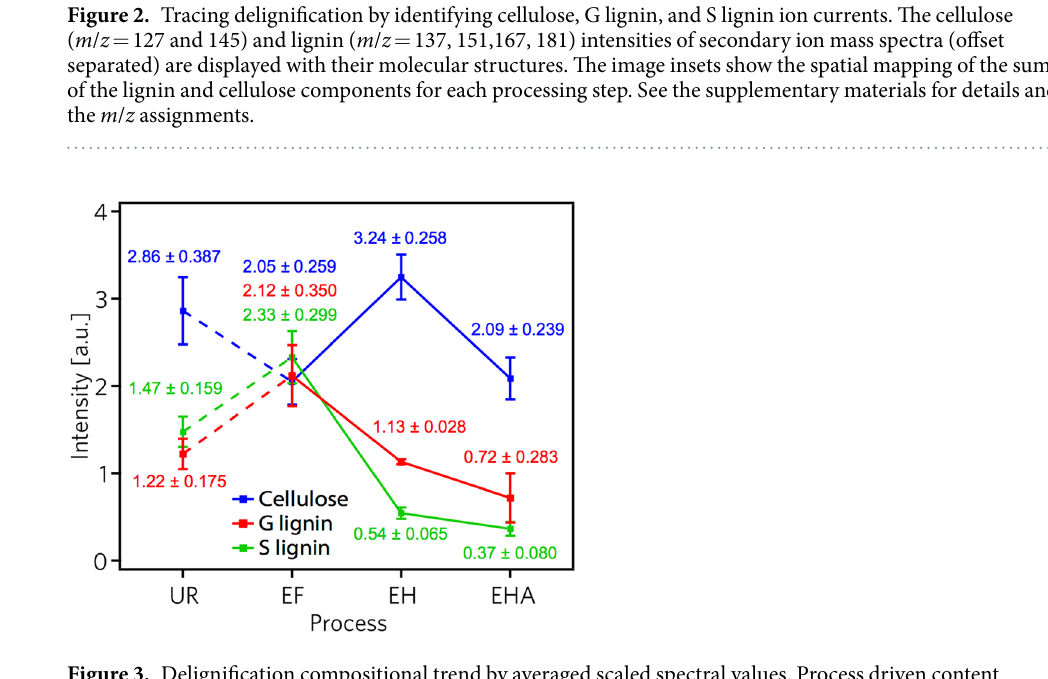
Figure 3. Delignification compositional trend by averaged scaled spectral values. Process driven content variations corresponding to UR, EF, holopulp EH, and alpha-cellulose EHA samples for the cellulose, guaiacyl (G) lignin, and syringyl (S) lignin ion fragmentations. The dashed lines indicate the UR sample content is not prepared to compare, whereas the solid lines compare the contents following extractive